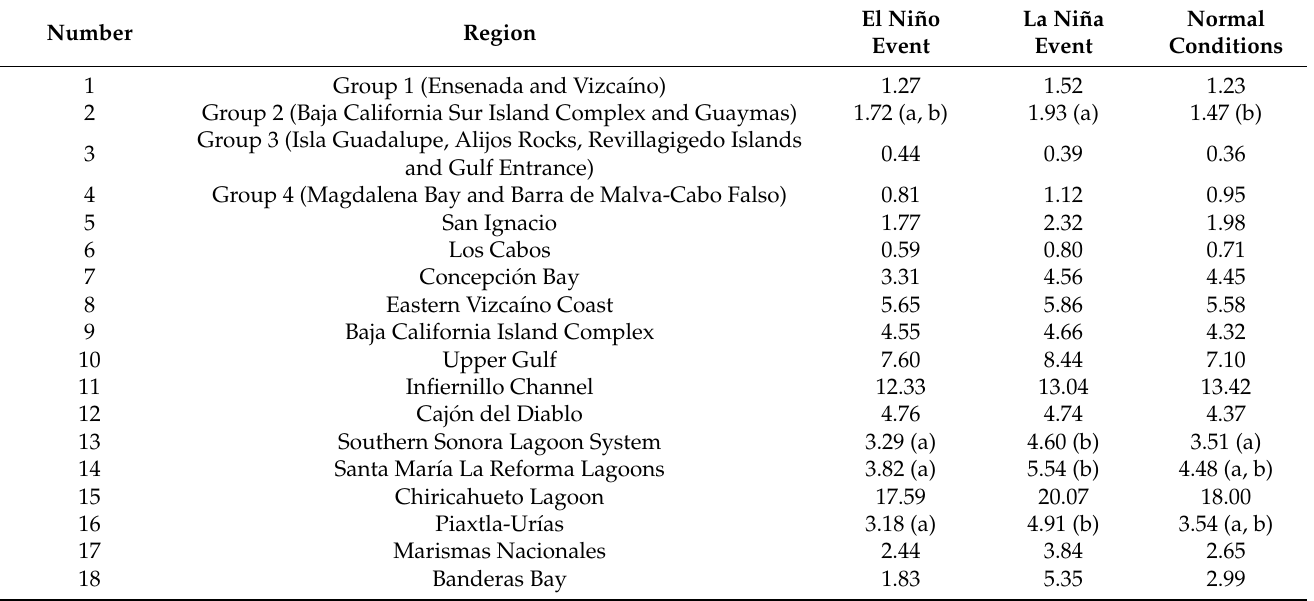
Table 4. Pairwise Permutation Test for the mean monthly autumn chlorophyll a (Chl a ) values during El Niño and La Niña events, as well as in normal conditions, in the regions of the Northwest Pacific Ocean, Mexico. Columns sharing the same letter (for a fixed row) are not statistically different.